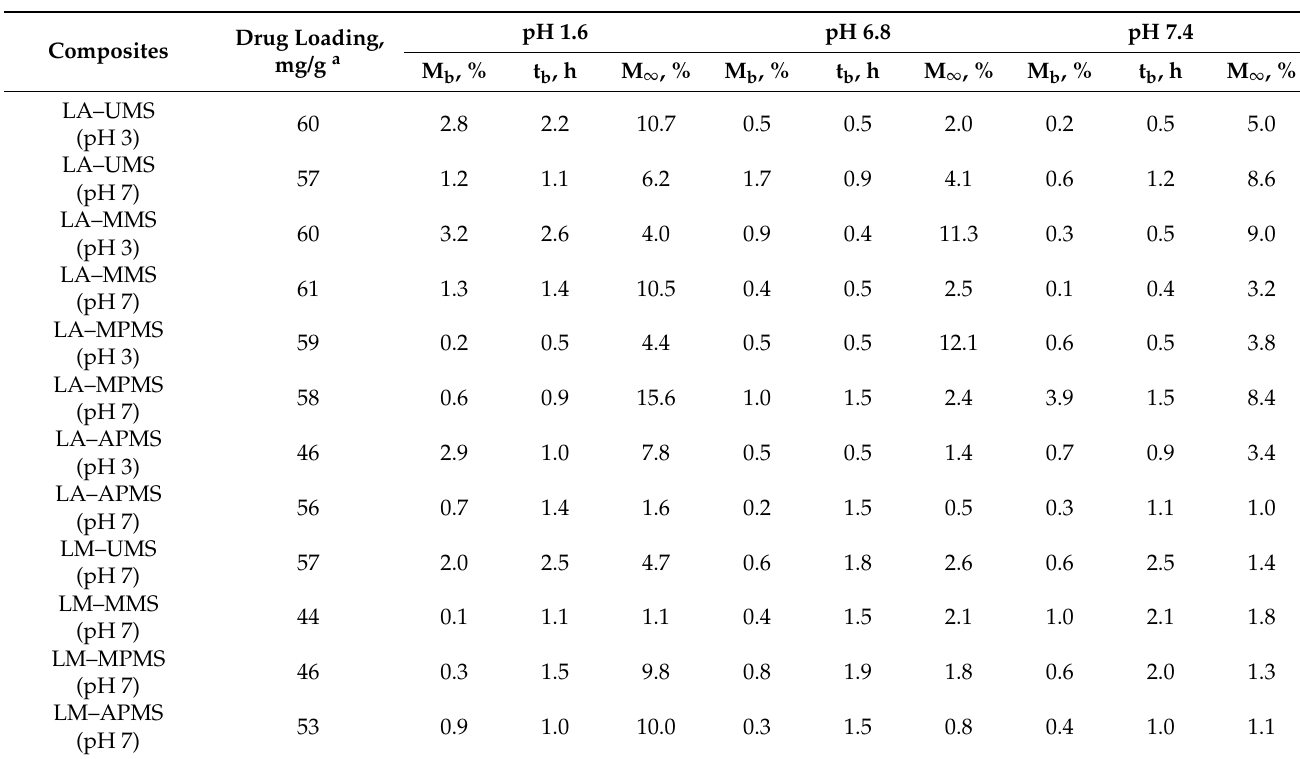
Table 2. Drug loading, burst release (M b ), burst time (t b ), and maximum amount of the released drugs (M ∞ ) in release media with pH 1.6, 6.8, and